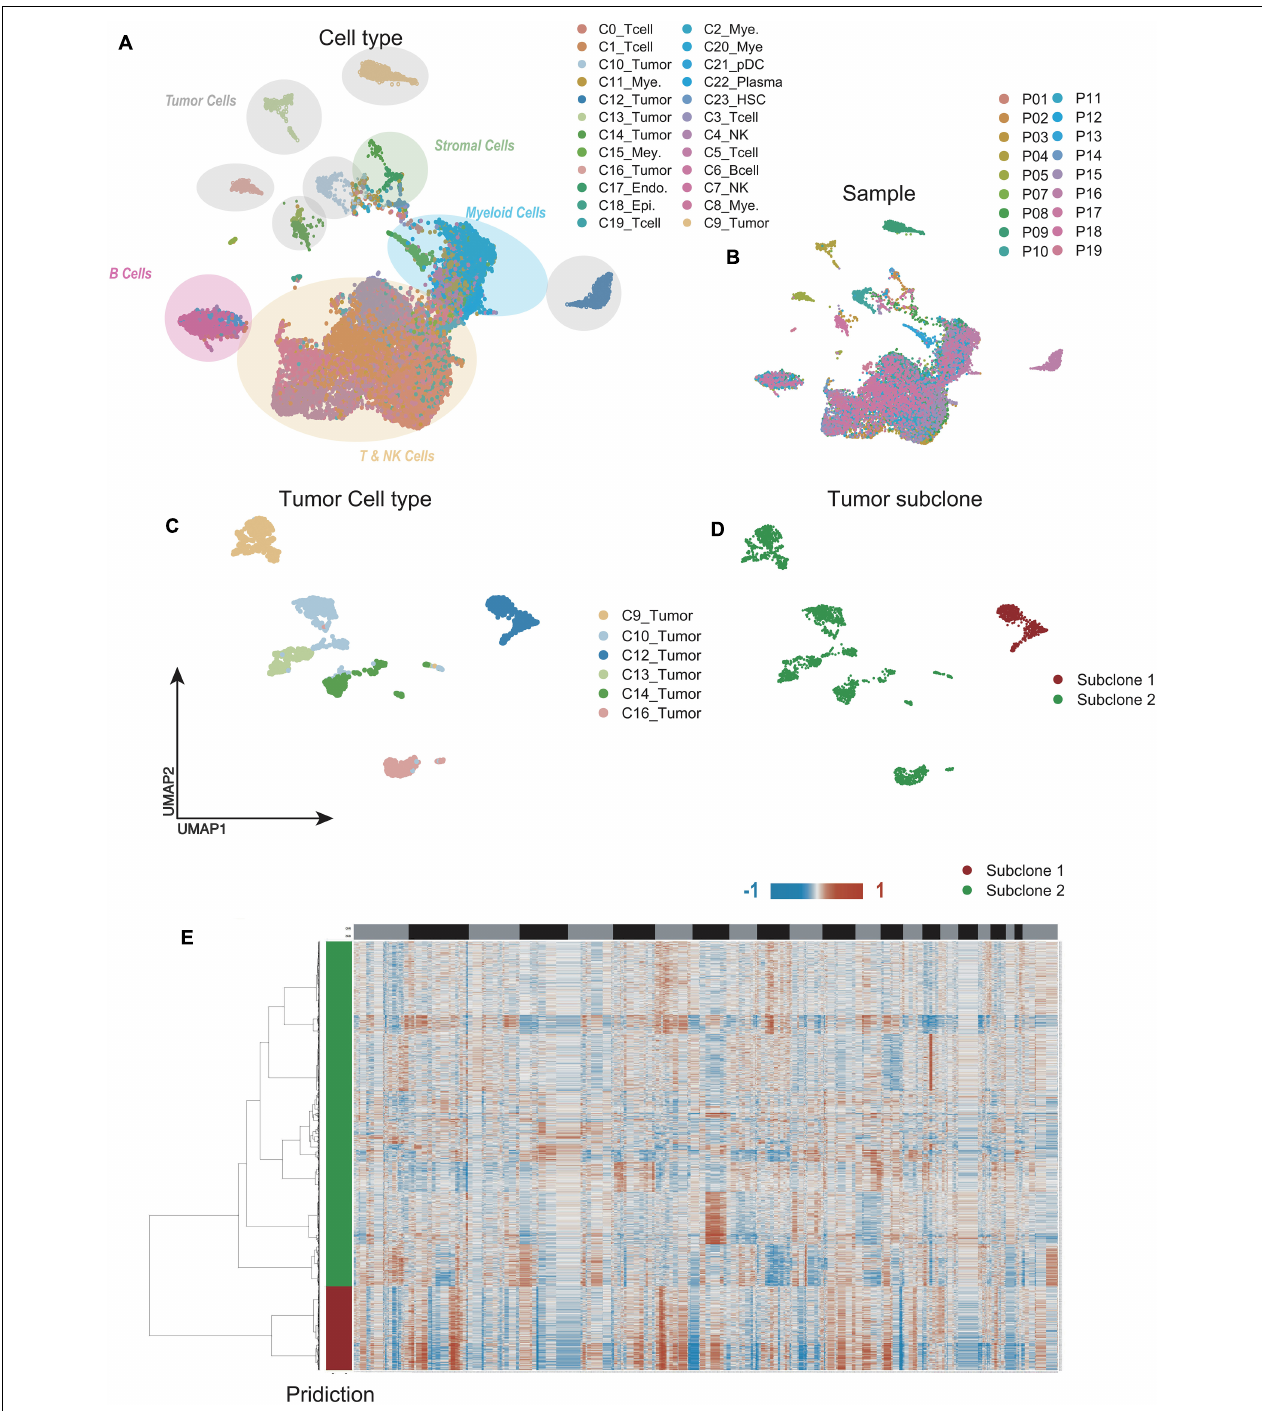
FIGURE 2 | Single-cell RNA sequencing (scRNA-seq) profiling of different malignant cell clusters. (A,B) The Uniform Manifold Approximation and Projection (UMAP) plot showing the annotation and color codes for cell types in hepatocellular carcinoma (HCC) (A) . Cells were further shown in different color by patient origin (B) . (C) The UMAP plot, showing only malignant cell clusters by Louvain algorithm. (D) With CopyKAT, malignant cell clusters were delineated into two subclones by single-cell copy number profiles inferred from scRNA-seq data. (E) Clustered heat maps of single HCC malignant cell copy number profiles in two major subclones.